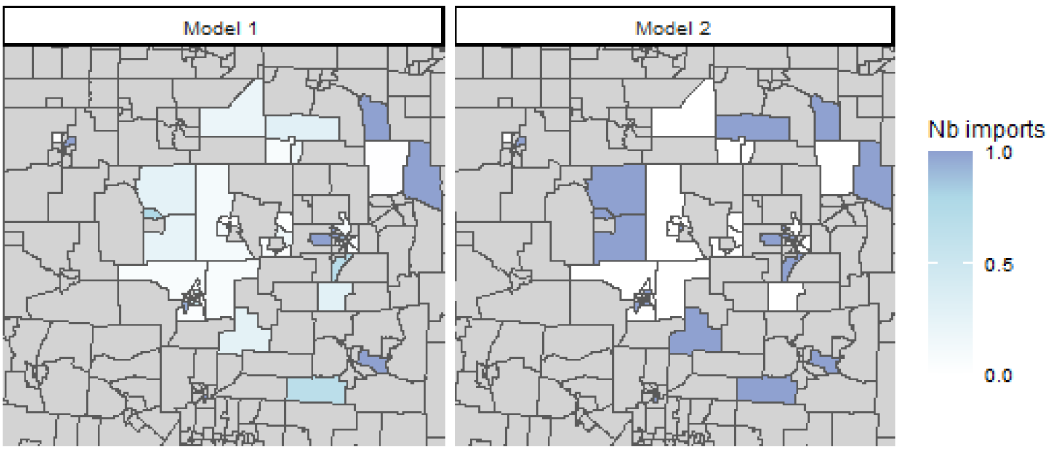
Figure 5. Average number of imported cases per census tract, regions where no case was reported are shown in